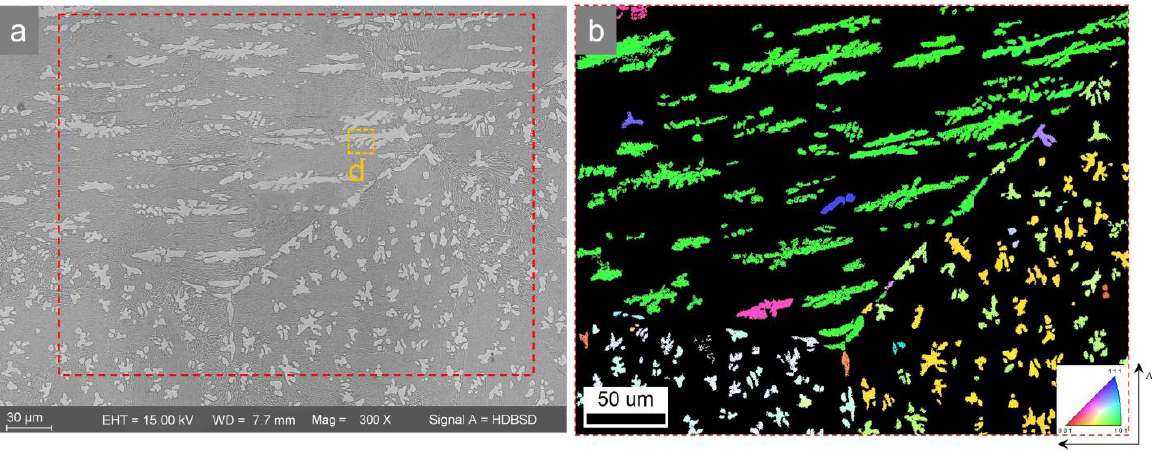
Figure 5. ( a ) the SEM image after rapid cooling (backscattering mode). ( b ) Full Euler image of the area marked by the red box in ( a ).